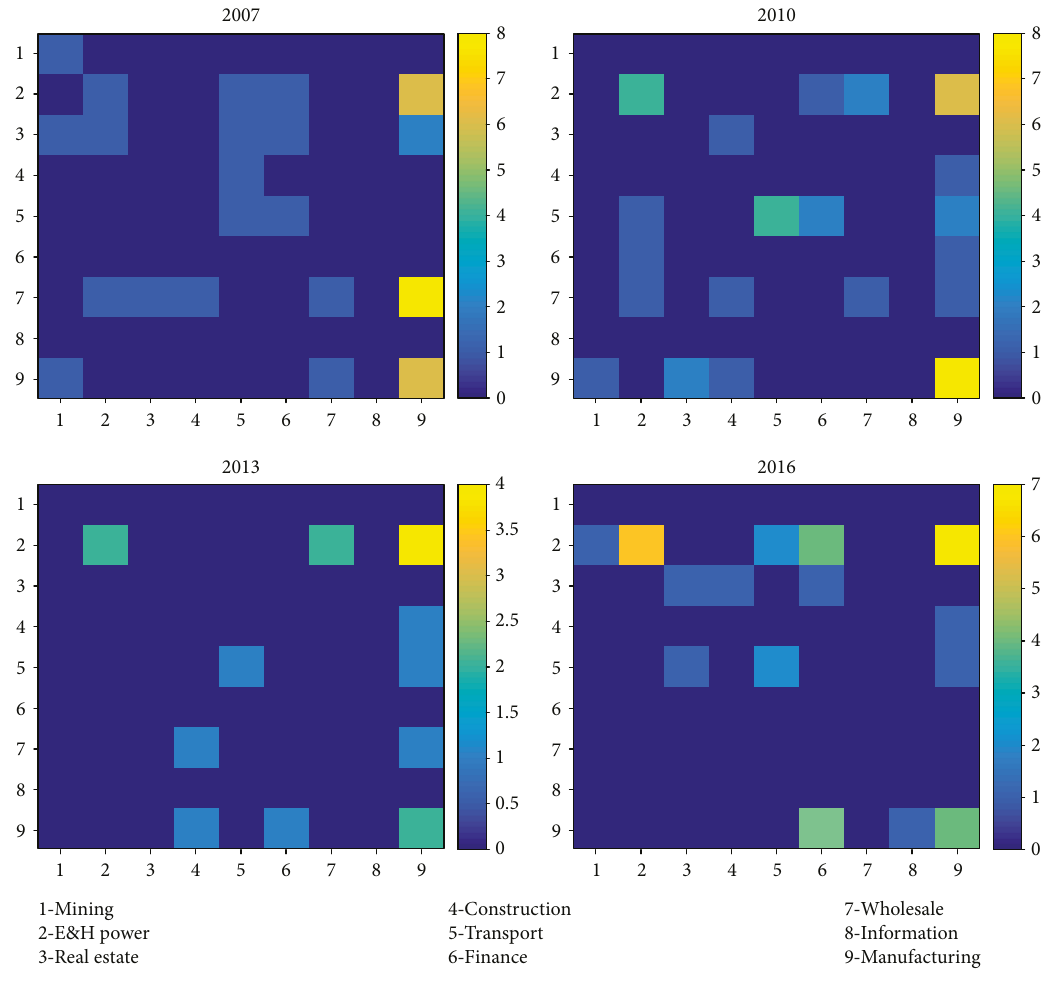
Figure 7: The number of indirect-holding relationships among industries in motif